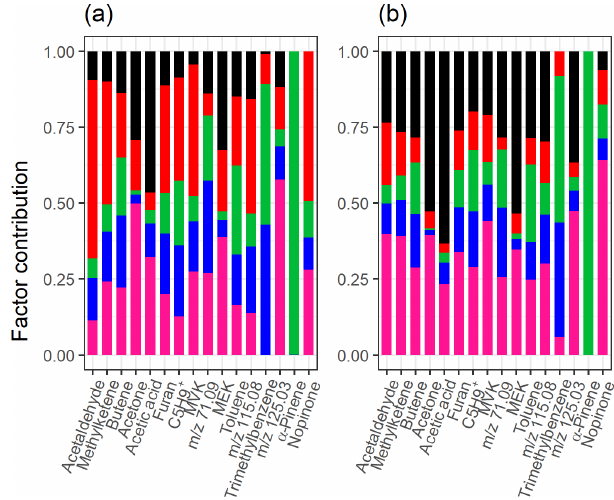
Figure 10. Total factor contribution of selected compounds from (a) NMF and (b) PMF with static error for the measured gas- phase (PTR-MS) data. Colour code identifying the factors is the same in both panels and is identified as later-forming and slowly forming products (black), early products (red), α -pinene precursor (green), background or car exhaust precursor (blue), and intermedi- ate products